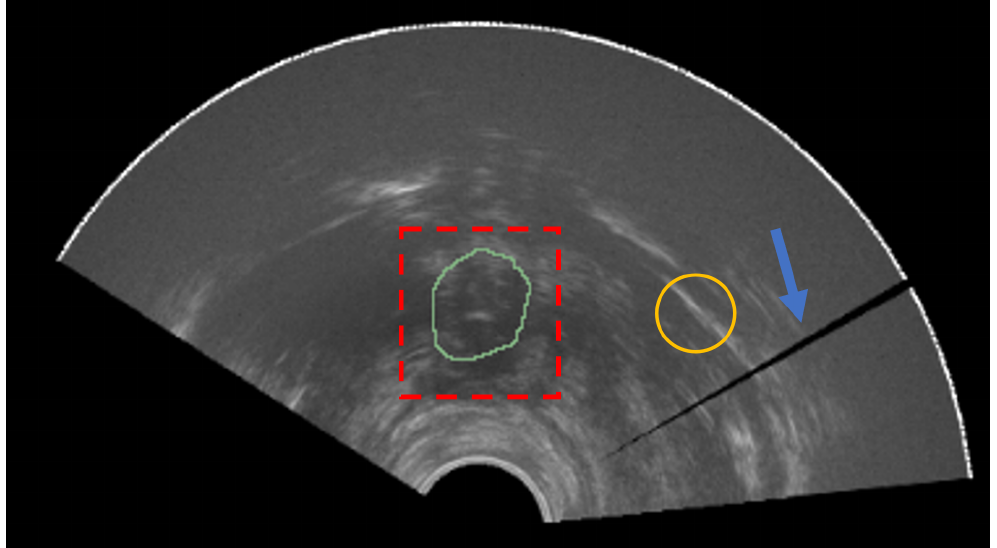
Figure 1. Prostate apex (ground-truth mask in green) is not easily distinguishable from the rest of the image (red dashed box). The yellow circle represents an example of a region with low signal-to-noise ratio. The blue arrow denotes a shadow